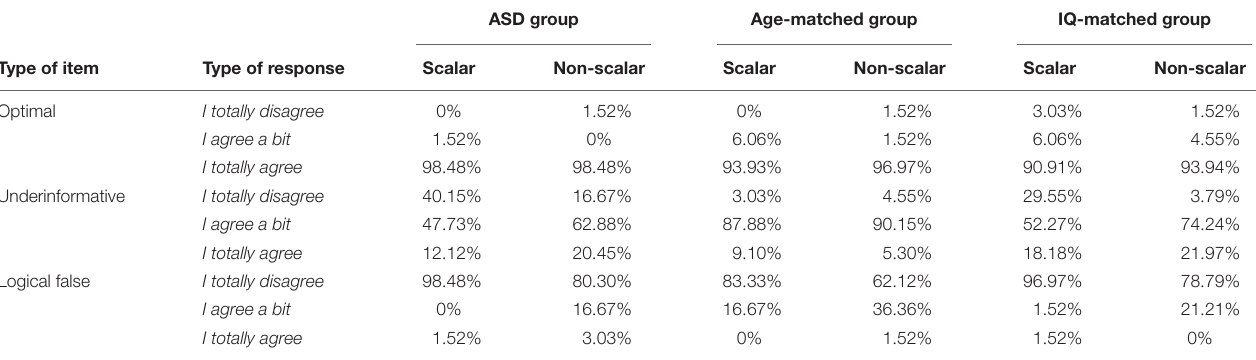
TABLE 4 | Experiment 2: percentage of each response type for the three item types.